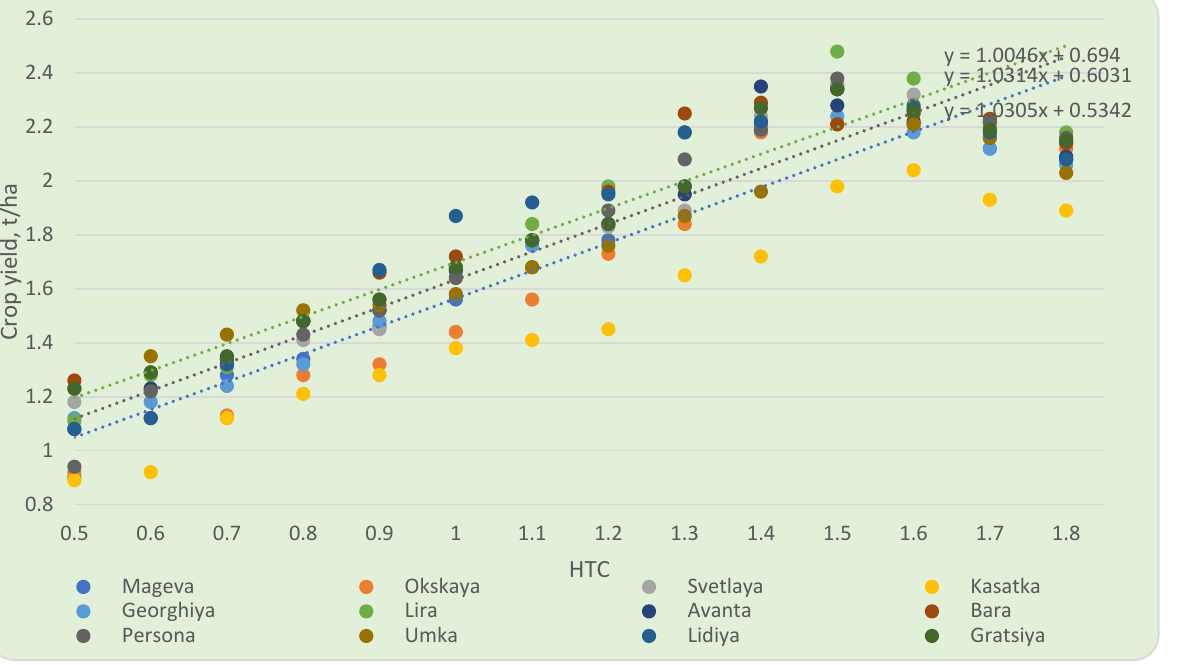
Figure 6. The correlation between soybean yield and the HTC of the growing season. Dotted lines are trend lines for Lira, Umka, Mageva varieties according to the colors in the legend.